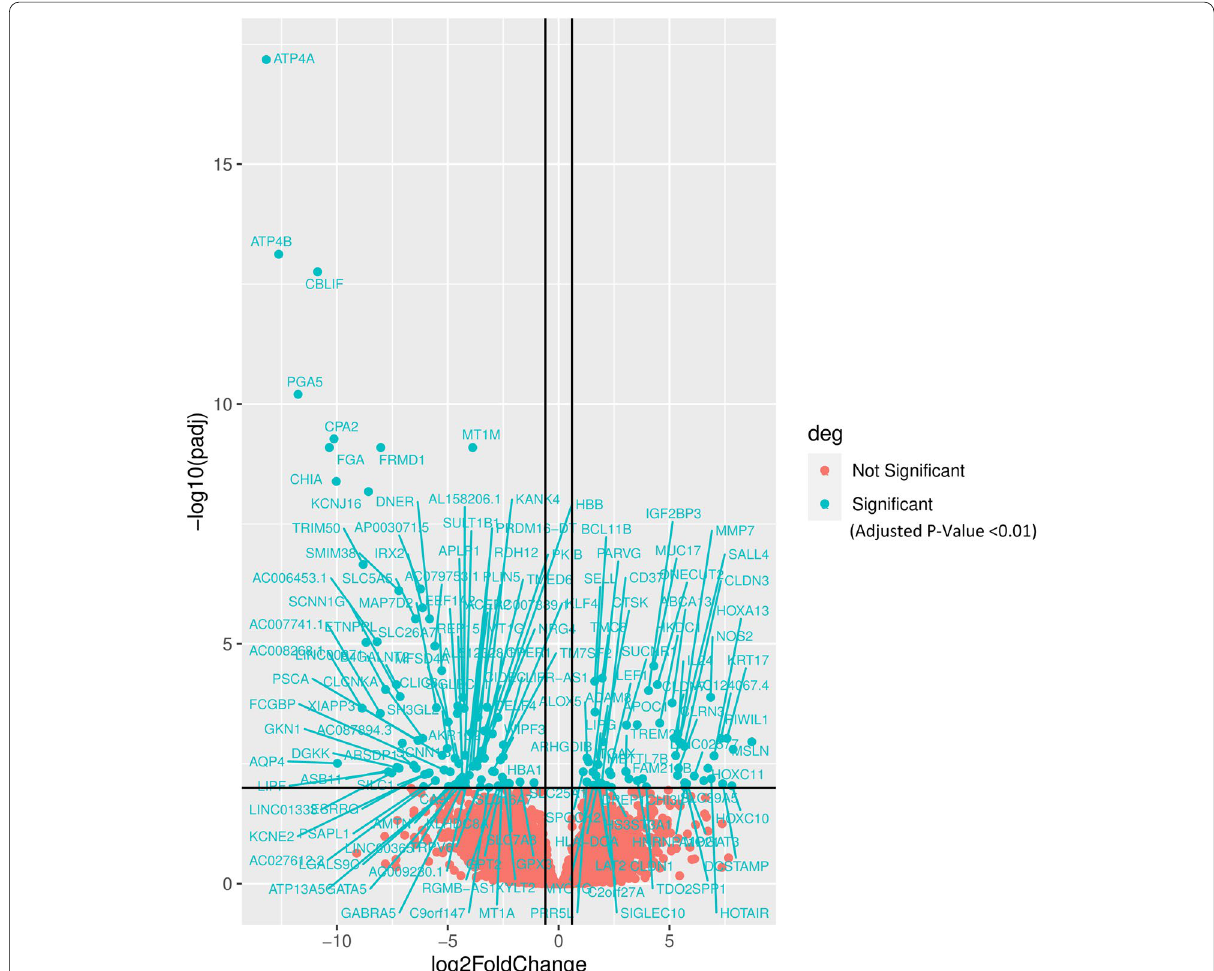
Fig. 1 Volcano plot showing the significant different ially expressed genes (DEGs). The adjusted P value less than 0.01 was set as statistically significant. log2foldchange > 1 is set to be upregulated and log2folchange < Table 2 Genes enriched in the Gene Ontology (GO) terms